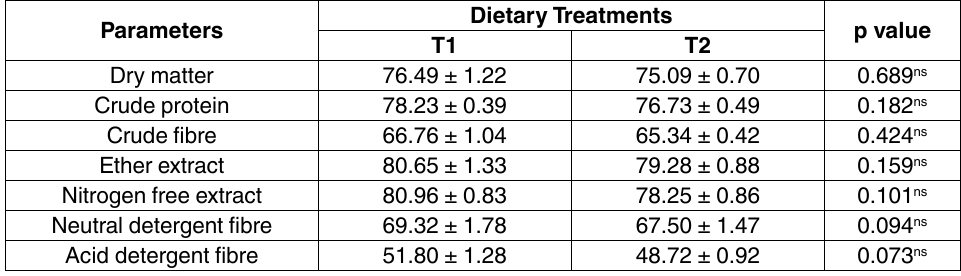
table 4. Data on the digestibility coefficient 1 of nutrients of the calves maintained on the two experimental rations,